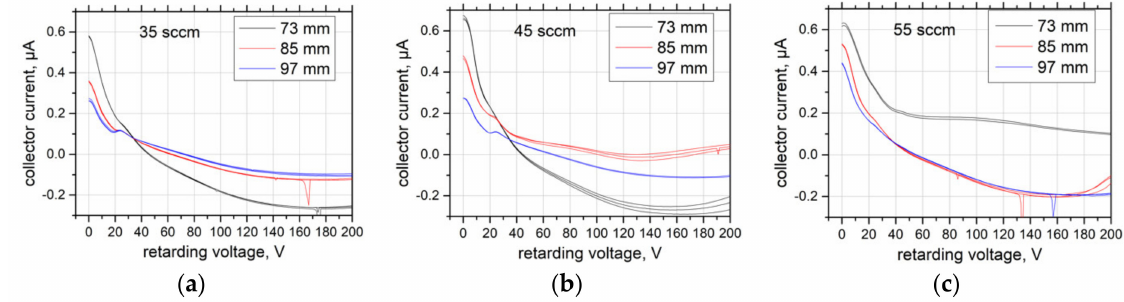
Figure 13. Measurement results for RPA. ( a )—35 sccm; ( b )—45 sccm; ( c )—55 sccm.